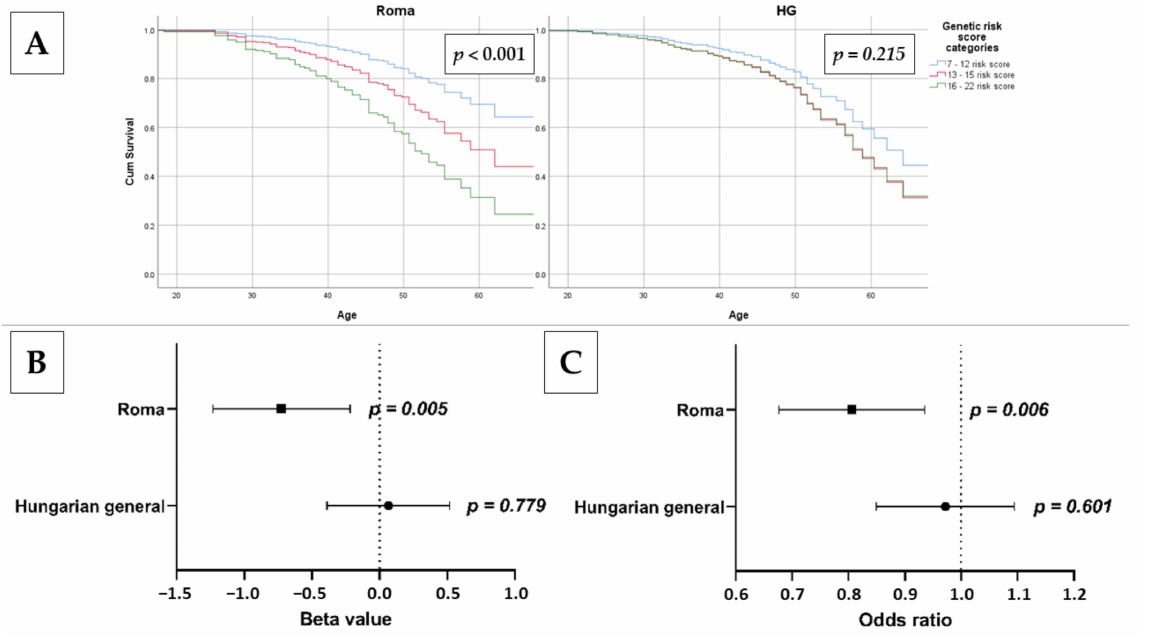
Figure 5. The association of oGRS with age at onset of IR using Cox regression analysis ( A ) and estimated longevity as continuous ( B ) and categorical: 20–34-year-old group was used as reference vs. 50–64 years old; ( C ) outcome in the Roma and Hungarian general (HG) populations. Bonferroni corrected p value: